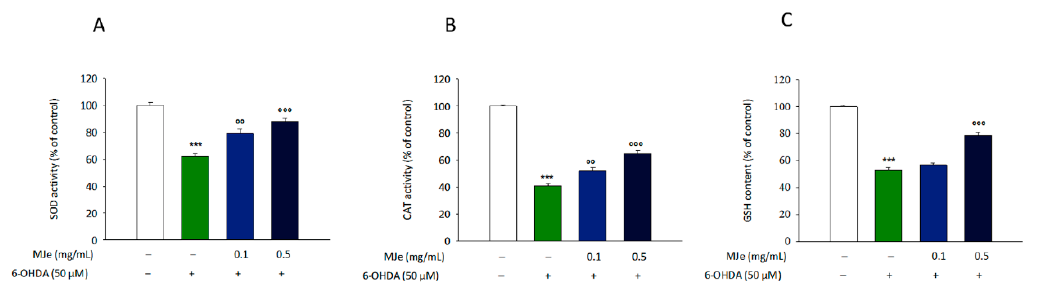
Figure 5. Effect of MJe on biomarkers of 6-OHDA-induced oxidative stress in SH-SY5Y cells. ( A ) Effect of MJe on the activity of SOD in 6-OHDA-treated SH-SY5Y cells; ( B ) Effect of MJe on the activity of CAT in 6-OHDA-treated SH-SY5Y cells; ( C ) Effect of MJe on the GSH levels in 6-OHDA-treated SH-SY5Y cells. Data are showed as the mean ± SEM of three experiments in triplicate (N = 9). *** p < 0.001 vs. ctrl; ◦◦ p < 0.01 and ◦◦◦ p < 0.001 vs. 6-OHDA 50 µ M.